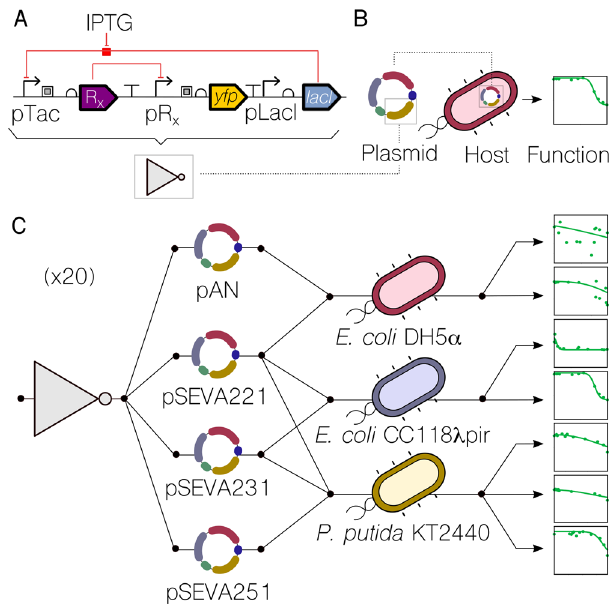
Fig. 1 Generating a library of gate-context devices. a Genetic inverters (NOT logic gates) were placed in between the pTac/LacI system (the input) and the yfp gene (the output). Key components are a repressor (R x ) and its cognate promoter (pR x ). b For a genetic construct to be measured, it needs to be cloned into a plasmid which, in turn, is transformed into a